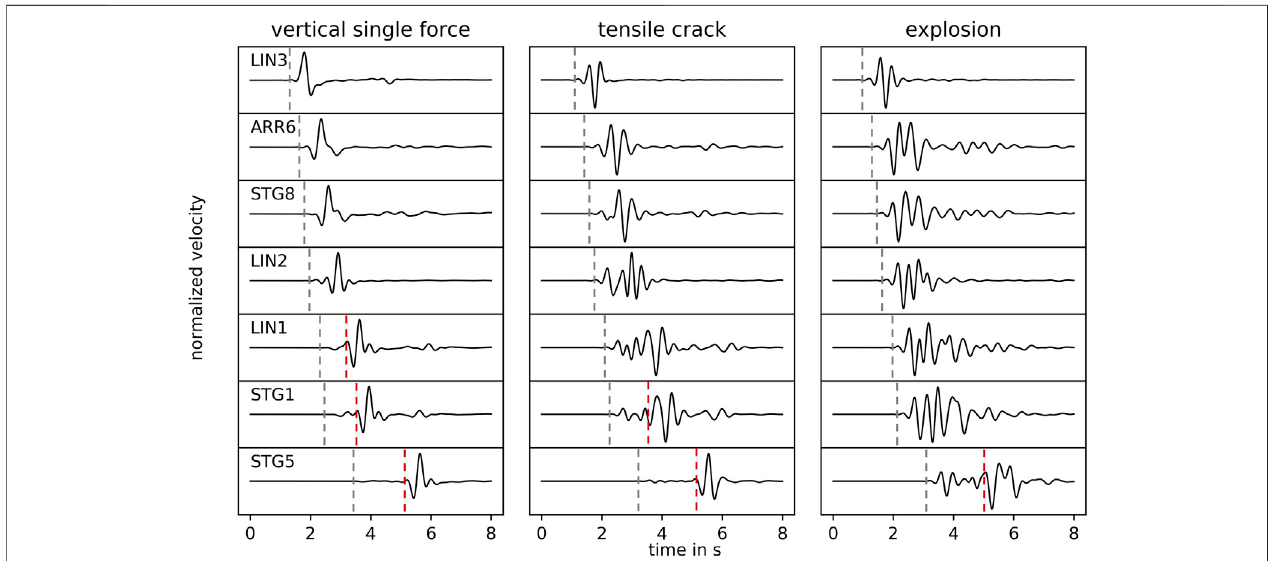
FIGURE8| Comparison ofsyntheticwaveforms ofthedifferentsource mechanisms using model2. Sourcedepthisset at600 mbelowEl Caliente. Seismograms are fi lteredbetween0.125and3 Hzandorderedbythedistanceofstationandsource.P-waveonsetsandS-waveonsets(ifrecognizable)aremarkedwithgrayandred dashed lines, respectively. While at the closest station (LIN3) only one phase can be seen, P- and S-wave onsets are separated at further stations (e.g. STG5). The ratio between P- and S-wave amplitudes vary for different source mechanisms. P-wave amplitudes are largest for explosions, but have much lower amplitudes in the VSF